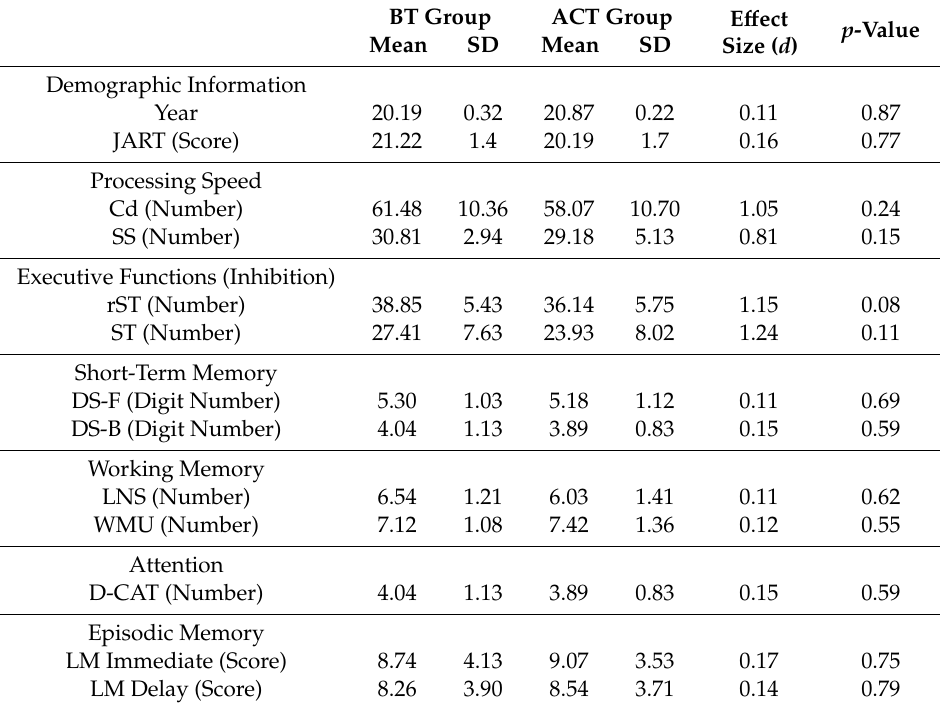
Table 1. Demographic information and cognitive function scores of both groups at baseline. BT